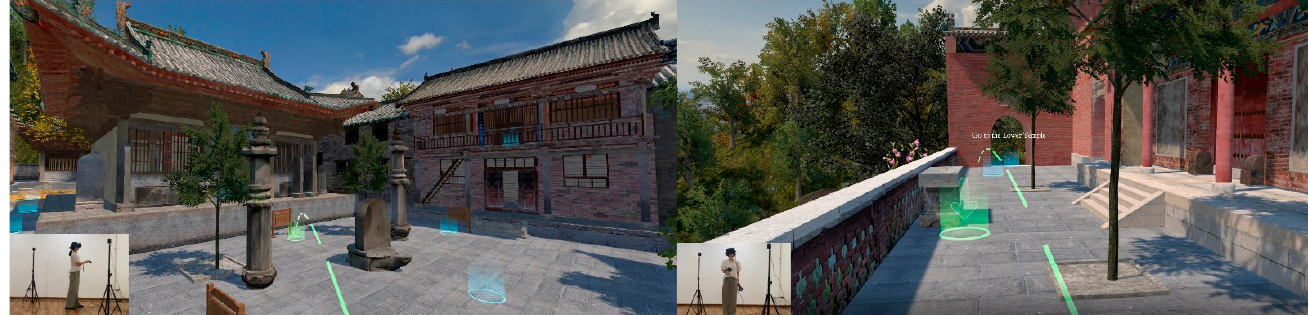
Figure 14. VR interaction with Qinglian Temple.